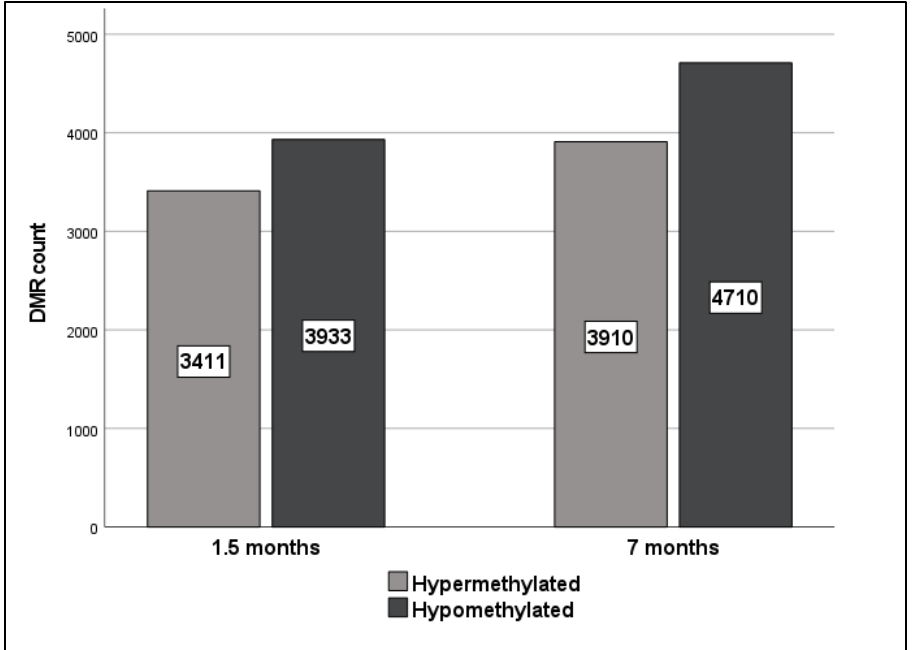
Figure 2. Significant hyper- (pale grey) and hypo- (dark grey) methylated DMR counts ( p -value < 0.05) identified by SureSelect MethylSeq in rats receiving 27.6 Gy FI relative to sham-irradiated rats at 1.5 and 7 months after irradiation.